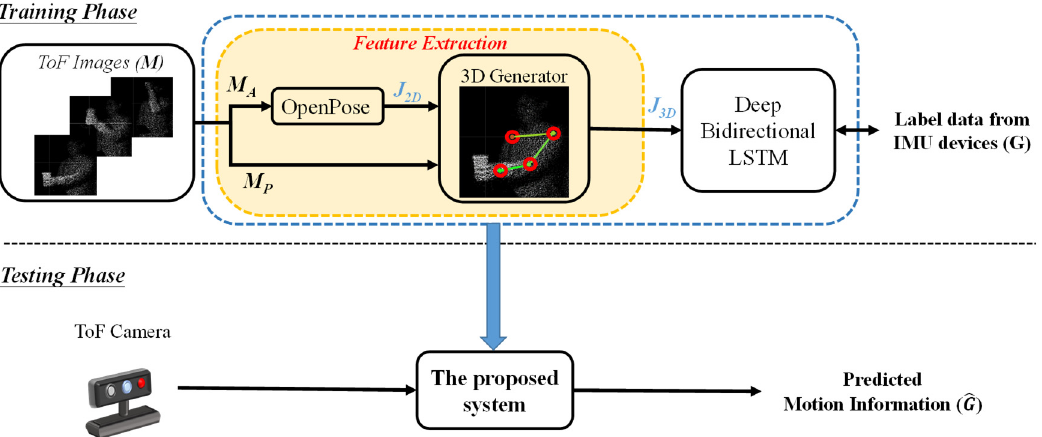
Figure 1. Structure of the proposed system.